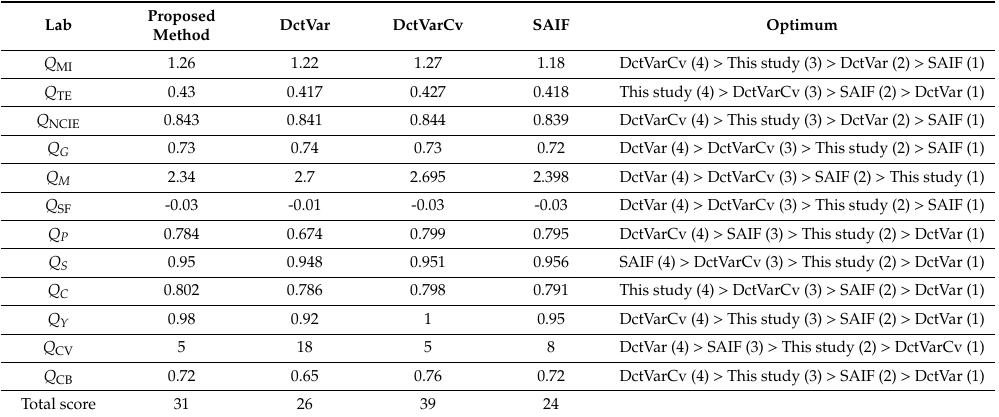
Table 5. List of lab fusion results and fusion quality indicators.